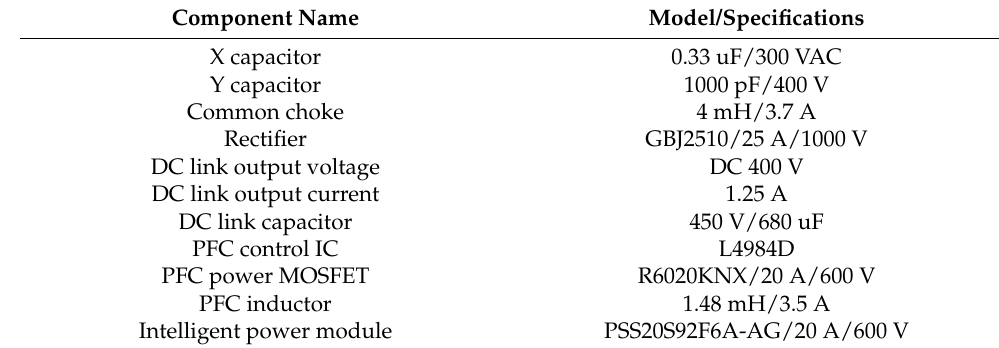
Table 5. Component specifications used in the developed inverter.